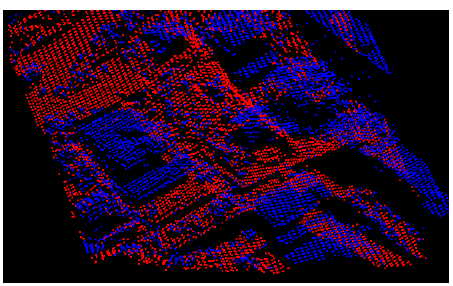
Figure 9. A step-wise pattern on the houses in Samp11. Red: ground; blue: non-ground.